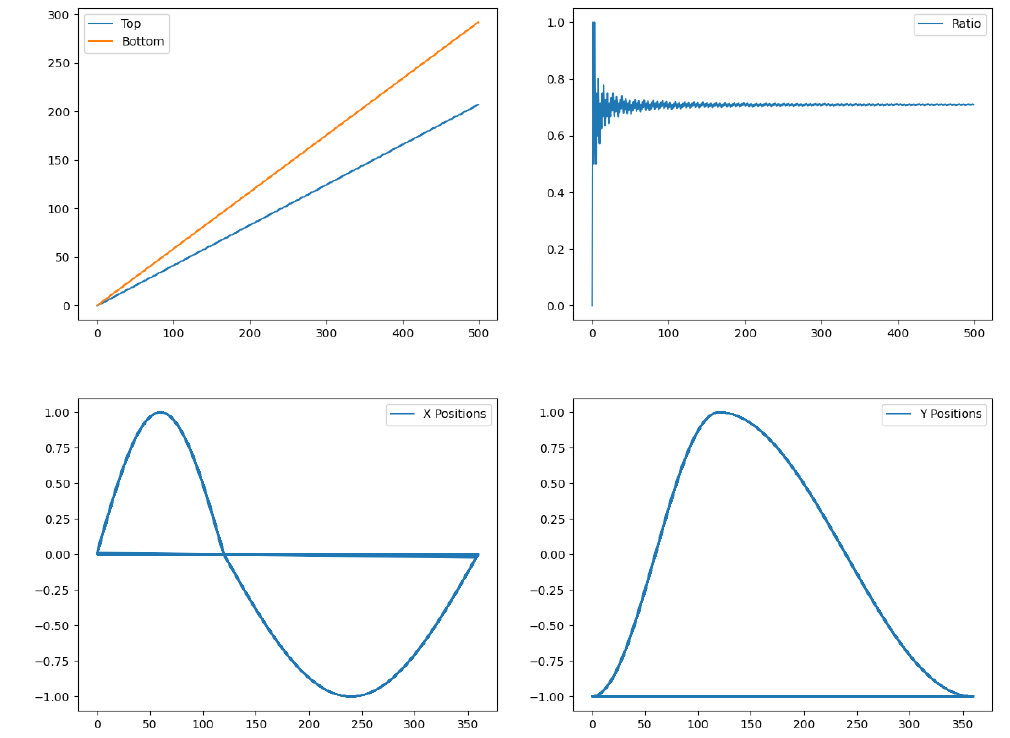
Figure 28. Clockwise, from the upper left: number of points on each side of the unit circle (side 7 is “top”, and side 5 is “bottom") after iterations of the multiplication by 3 on number 1. The top/bottom ratio, on the next figure, converges to approximately 0.7. The next two figures display the cosine and sine of the multiplication by 3 of each point of the unit circle: on one third of the domain, this operation multiplies the angle of the starting point by 1.5, and on the other two thirds, the operation multiplies the angle by 0.75, thus explaining the asymmetry of the truncated caustic, in turn explaining the non-ergodicity of the 3 map on the binary tree embedded in the unit ×